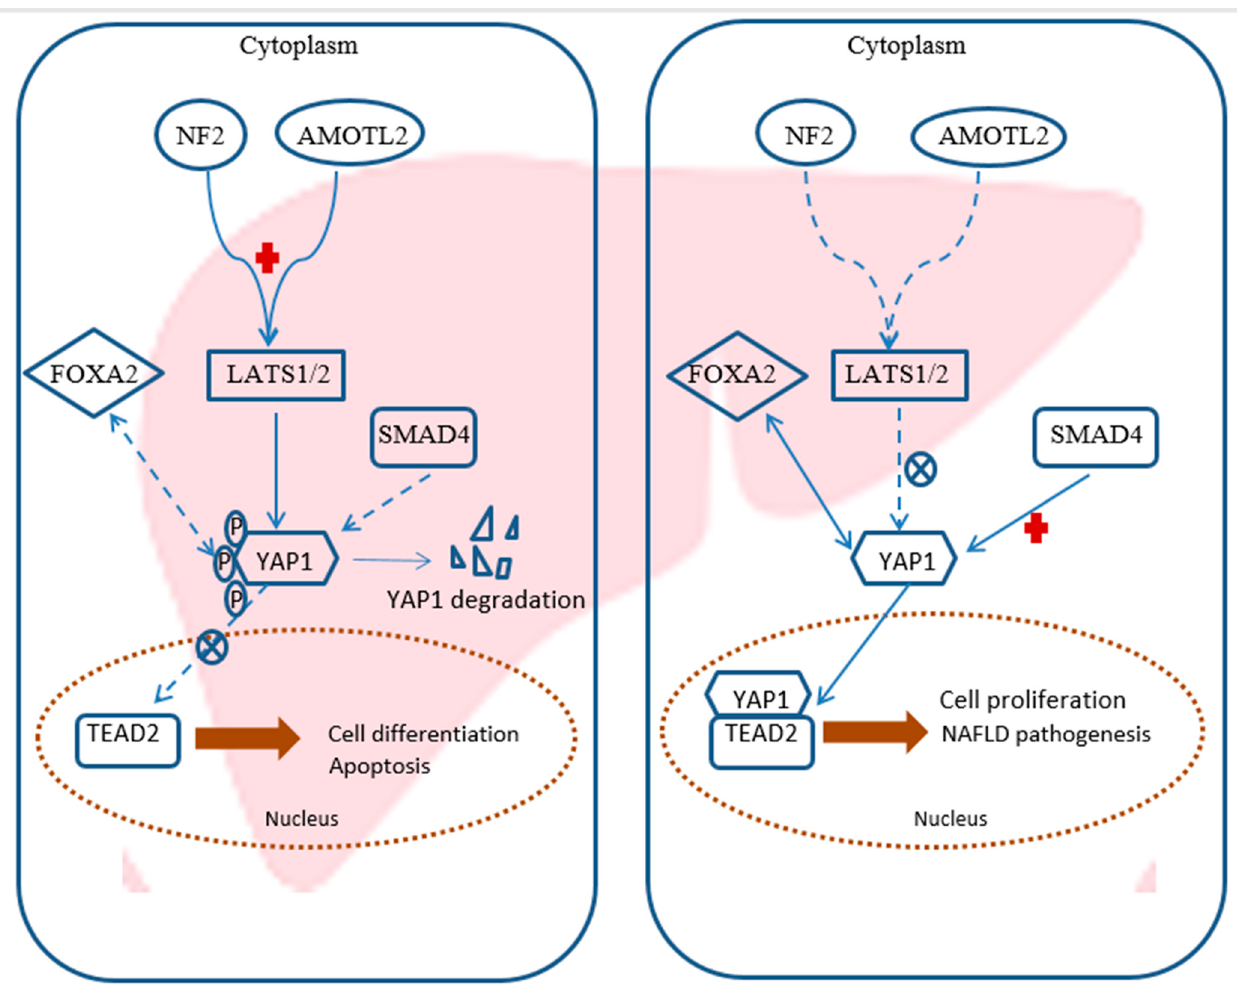
Figure 5. Schematic diagram for the chosen key genes patterns in control and NAFLD model.